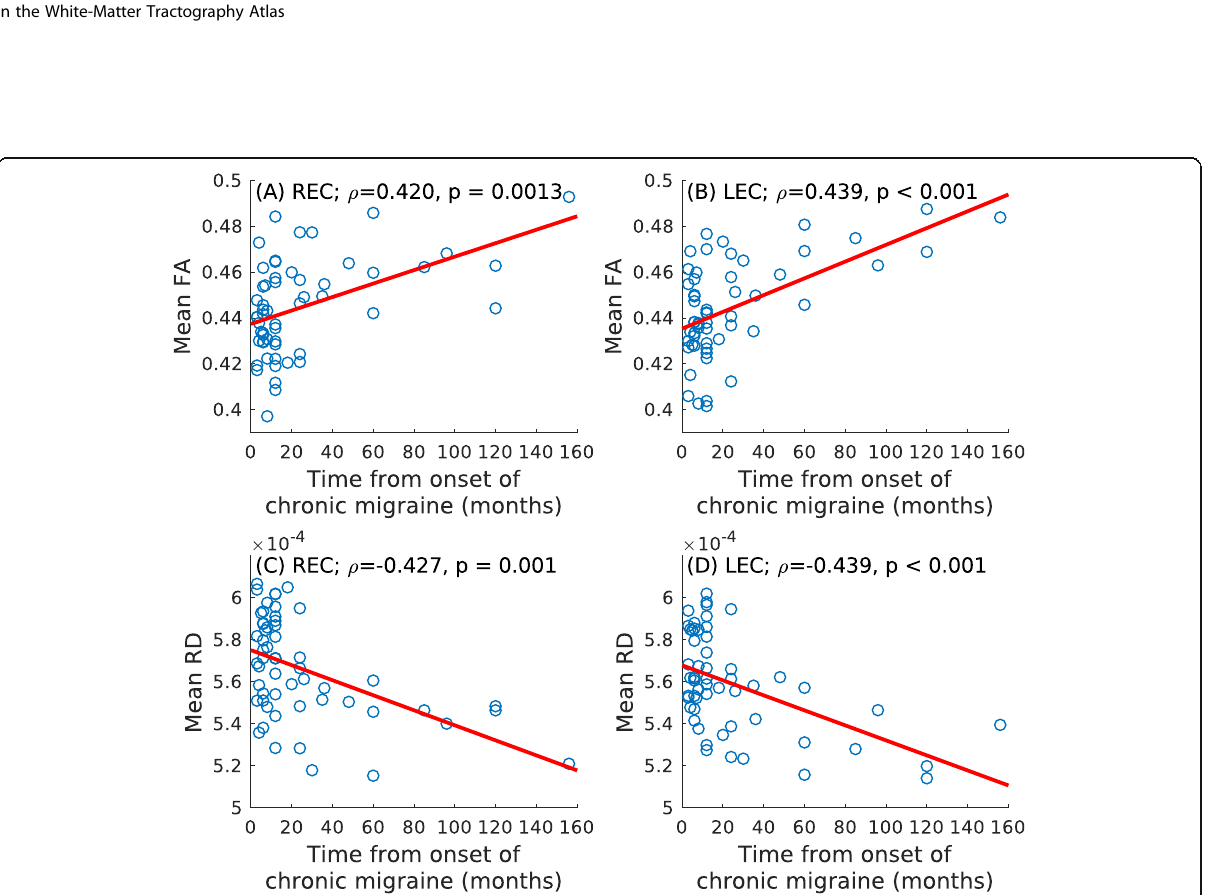
Fig. 2 Association graphs between clinical parameters and DTI measures. Significant association with the mean FA in the bilateral external capsule is shown in ( a ) and ( b ). Significant association with the mean RD is shown in ( c ) and ( d ). LEC = left external capsule; REC = right external